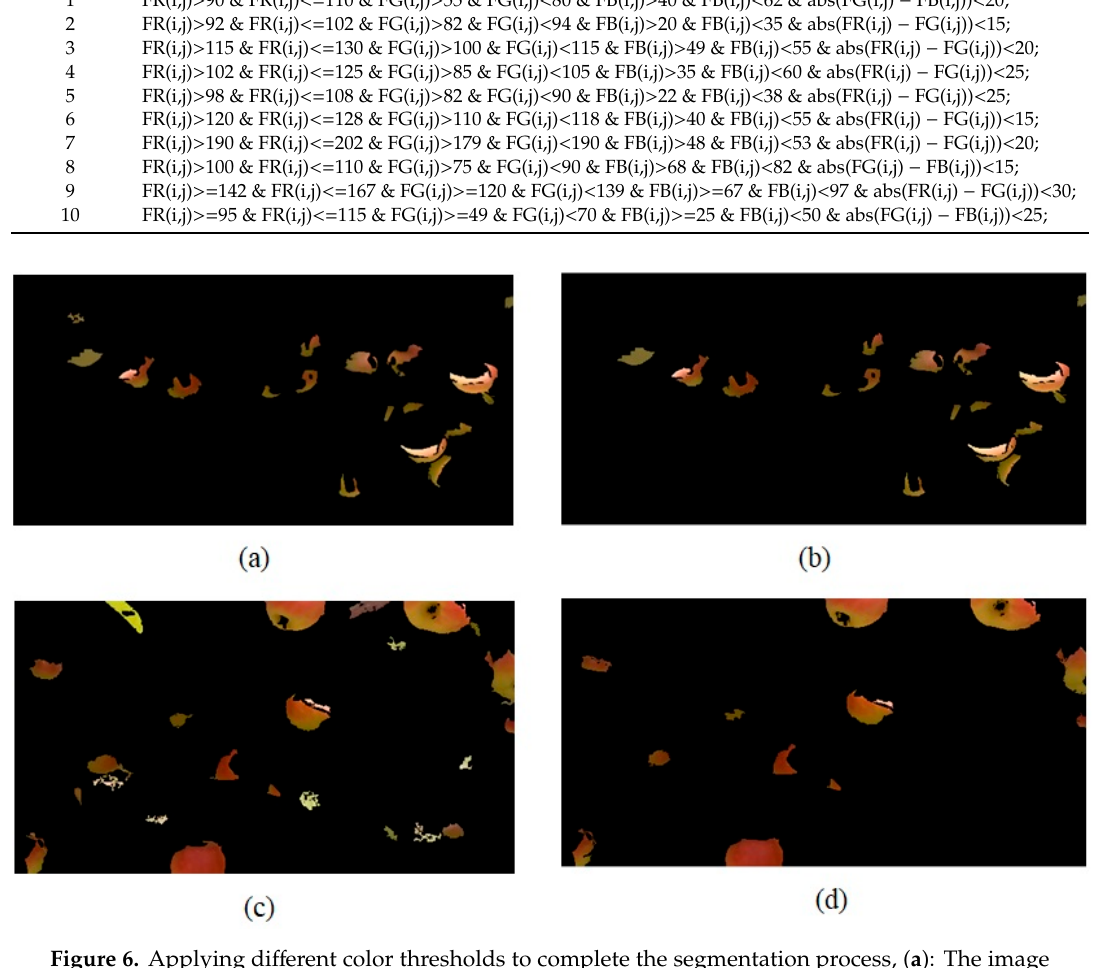
Figure 6. Applying different color thresholds to complete the segmentation process, ( a ): The image before applying threshold, ( b ): The image after applying threshold 6 in Table 3, ( c ): The image before applying threshold, ( d ): The image after applying threshold 5 in Table 3.